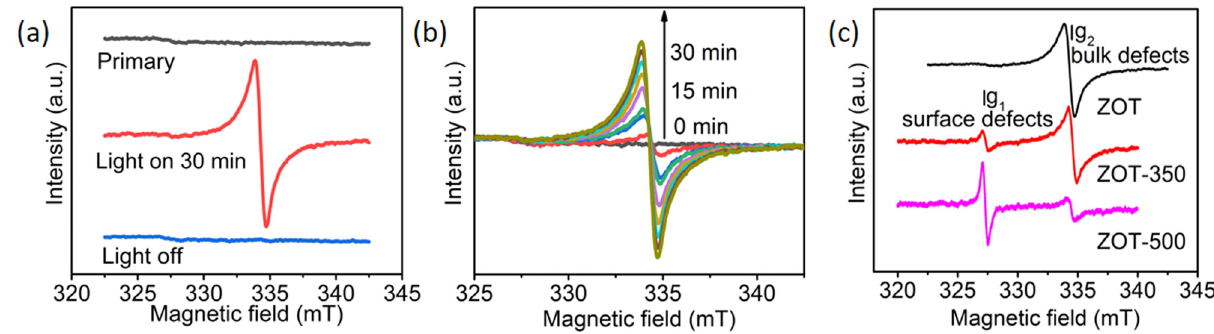
Figure 6: ESR spectra of ( a ) ZOT before, during, and after light irradiation for 30 min; ( b ) ZOT under light irradiation for various times; and (